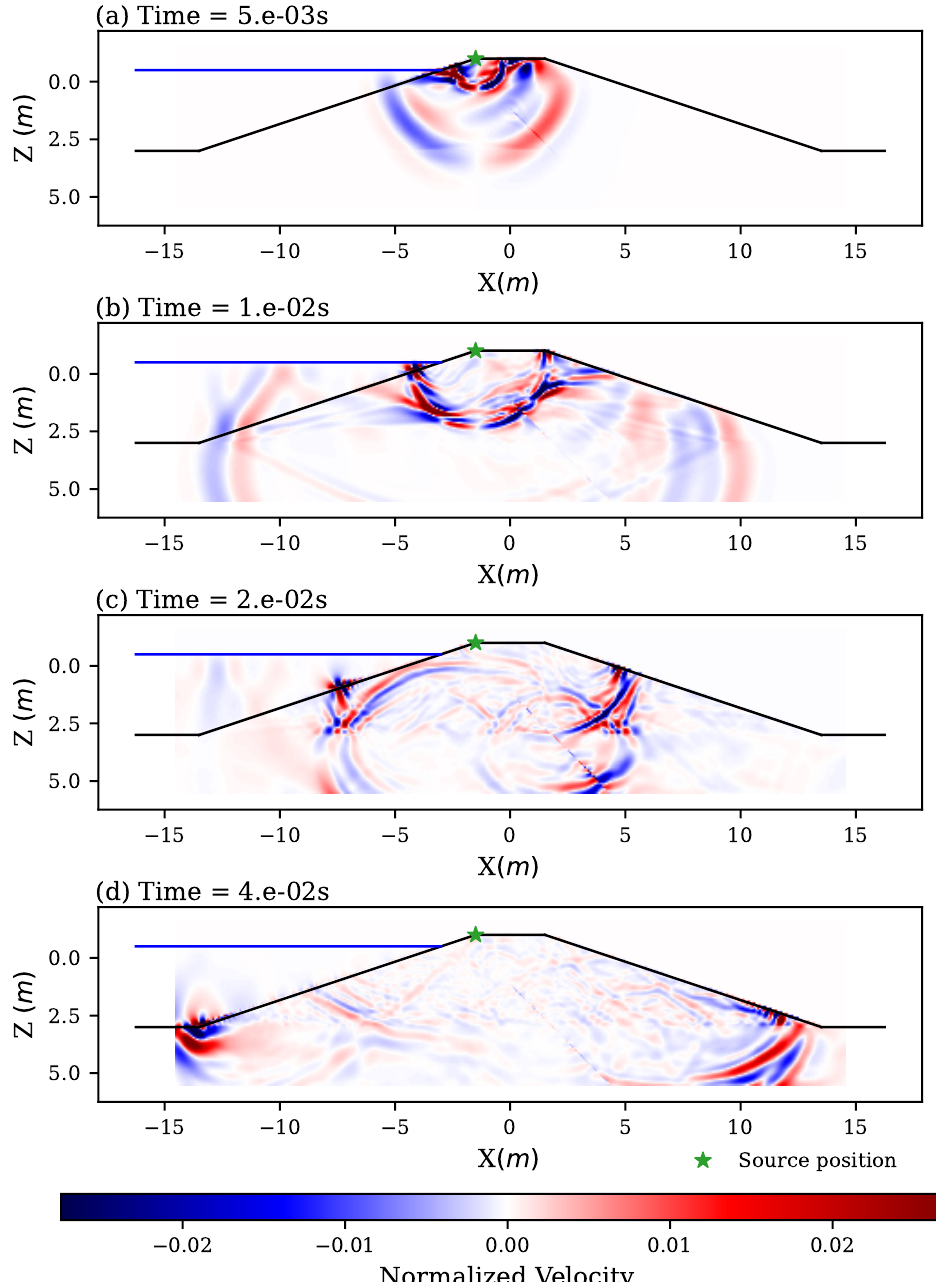
Figure 12. Horizontal component of particle velocity ( v x ) , normalized to the velocity wavelet at the excitation point, in the forward seismic